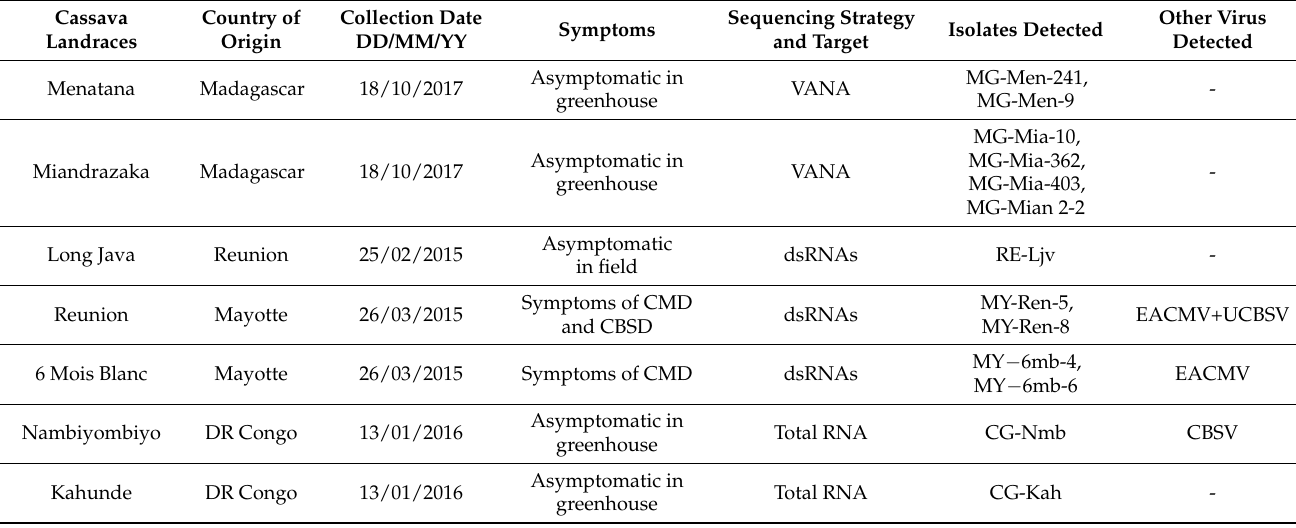
Table 1. Identity and origin of cassava landraces used and indication on the high-throughput sequencing (HTS) protocol performed on these